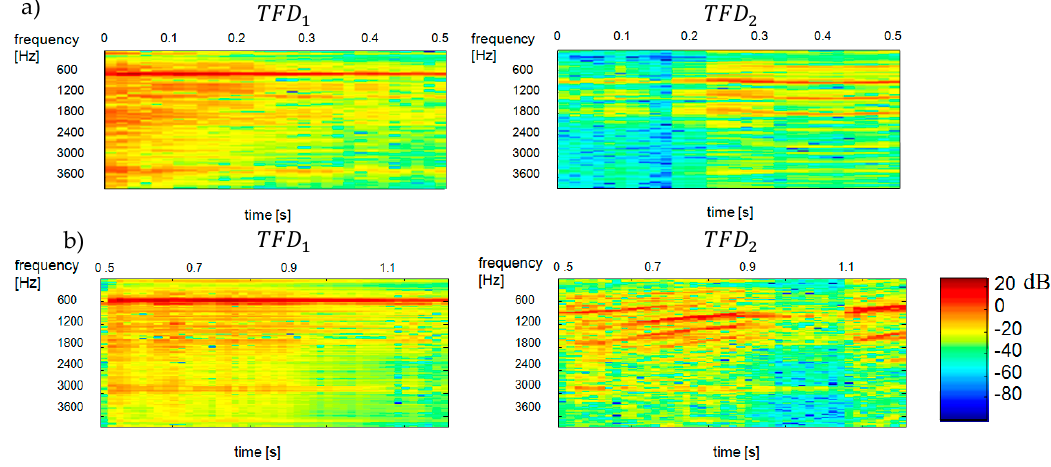
Figure 7. Reconstructed spectrograms (spectra) of TFD 1 and TFD 2 components as a results of hierarchical clustering with Euclidean distance for TFD i components. TFD 1 —ringer, TFD 2 —baby: ( a )